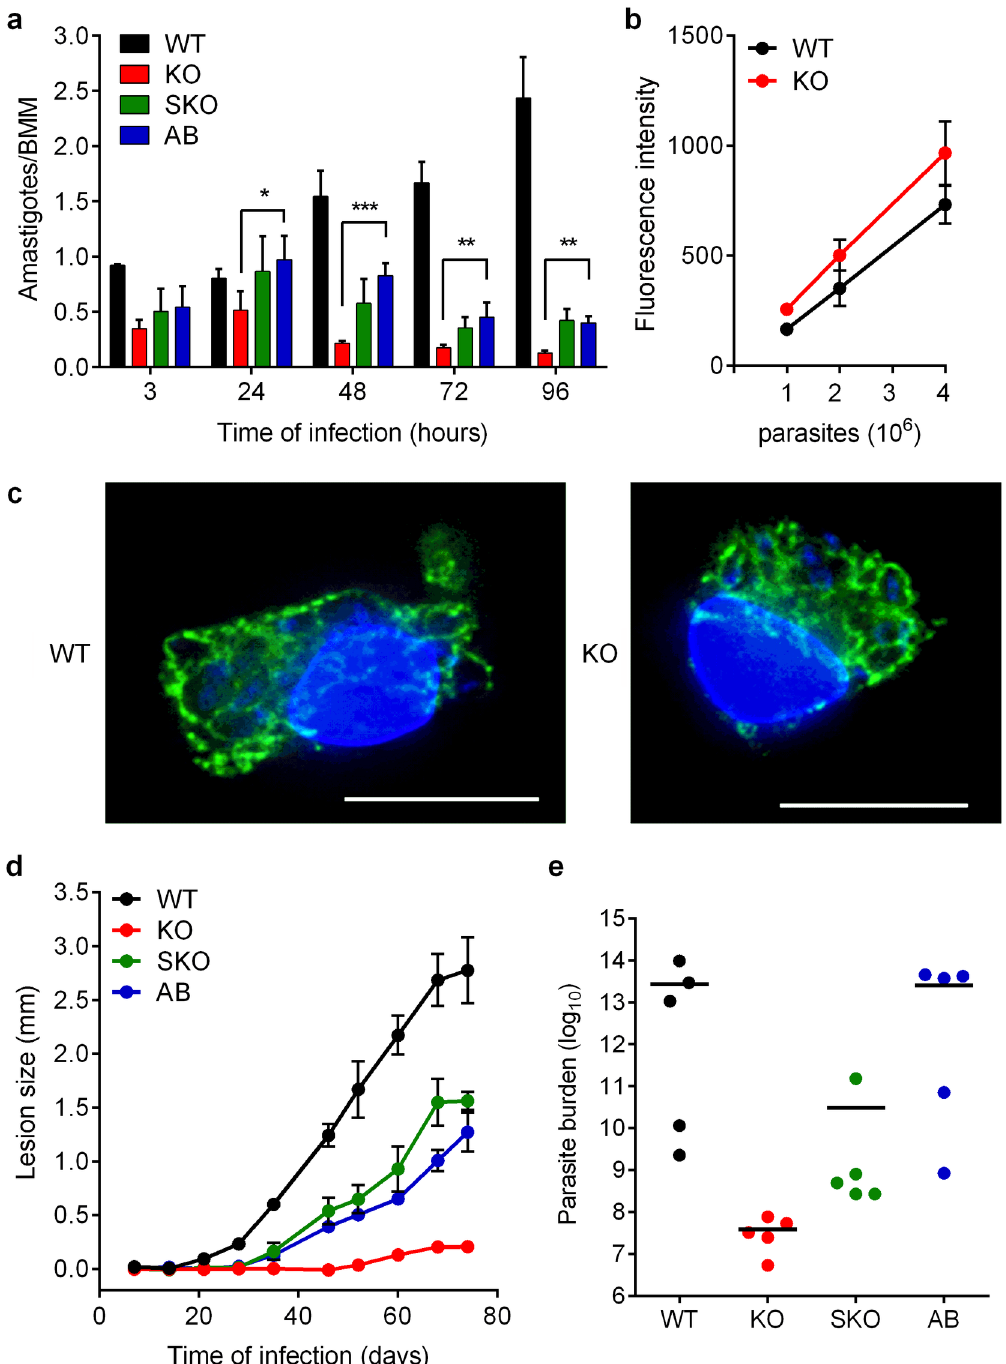
Fig 6. LIR1 deficiency markedly reduces L . amazonensis virulence. (a) Microscopic quantification of intracellular parasites in BMM infected with purified metacyclic forms of wild type (WT), LIR1 double knockout (KO), LIR1 single knockout (SKO) and add-back (AB) L . amazonensis (multiplicity of infection = 3) for 3, 24, 48, 72 and 96 h. The values represent the mean ± SD of triplicate determinations in one experiment that is representative of 3 independent experiments. (cid:3) p = 0.031 (KO vs. AB 24 h), (cid:3)(cid:3) p = 0.0063 (KO vs. AB 72 h); p = 0.0019 (KO vs. AB 96 h); (cid:3)(cid:3)(cid:3) p = 0.0007 (KO vs. AB 48 h). (b) AlamarBlue fluorescence viability assay of 10 6 , 2x10 6 and 4x10 6 purified metacyclics purified from WT and KO promastigote cultures. The values represent the mean ± SD of 3 independent experiments. (c) Immunofluorescence deconvolution images of BMM infected for 3 h with WT and KO metacyclic promastigotes. Blue, DAPI DNA staining; green, lysosomes and PV membranes stained